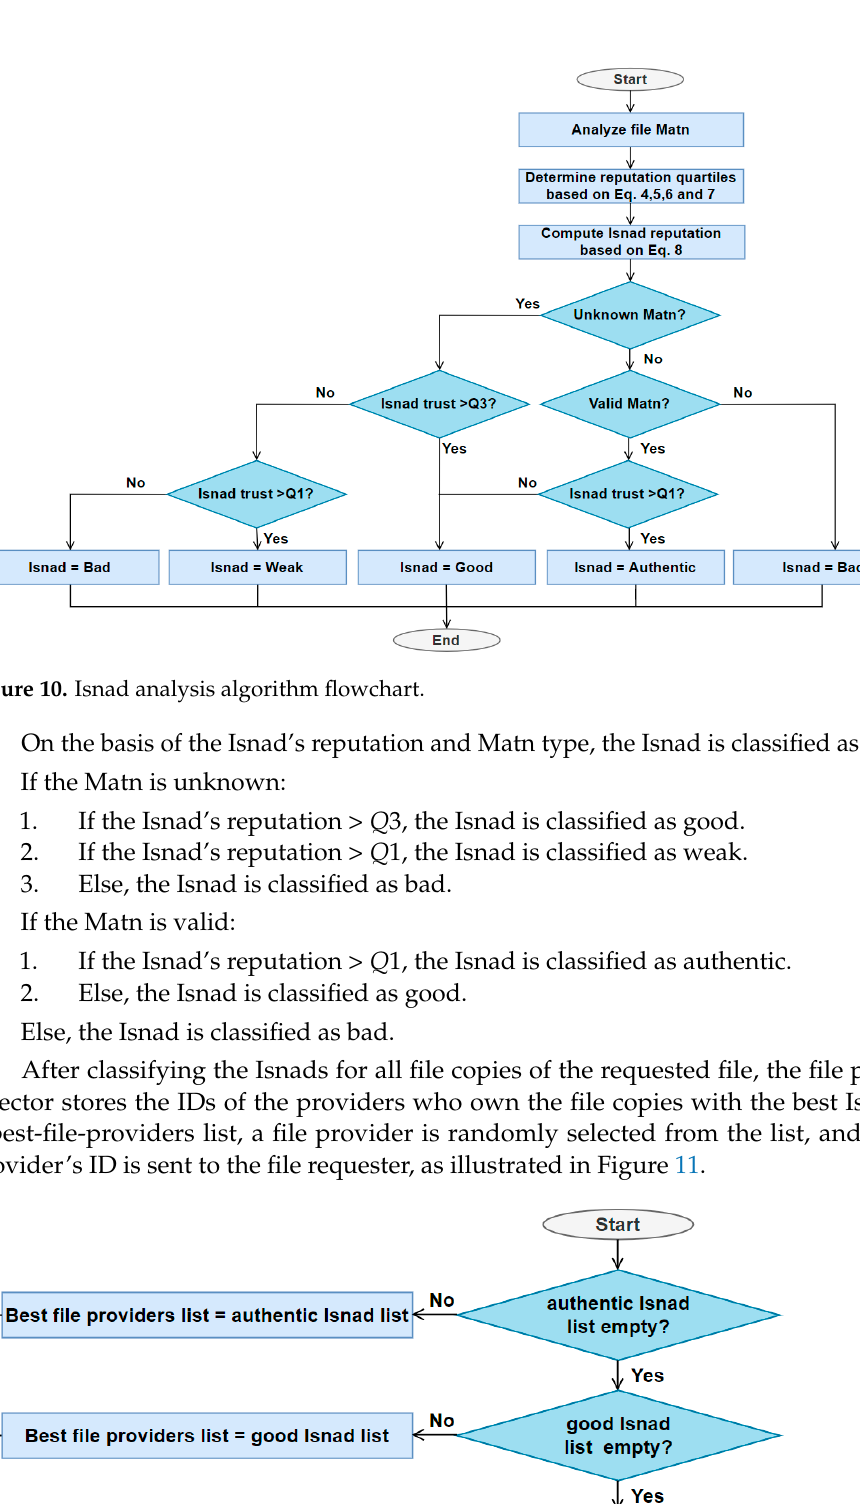
Figure 9. Matn analysis algorithm flowchart.